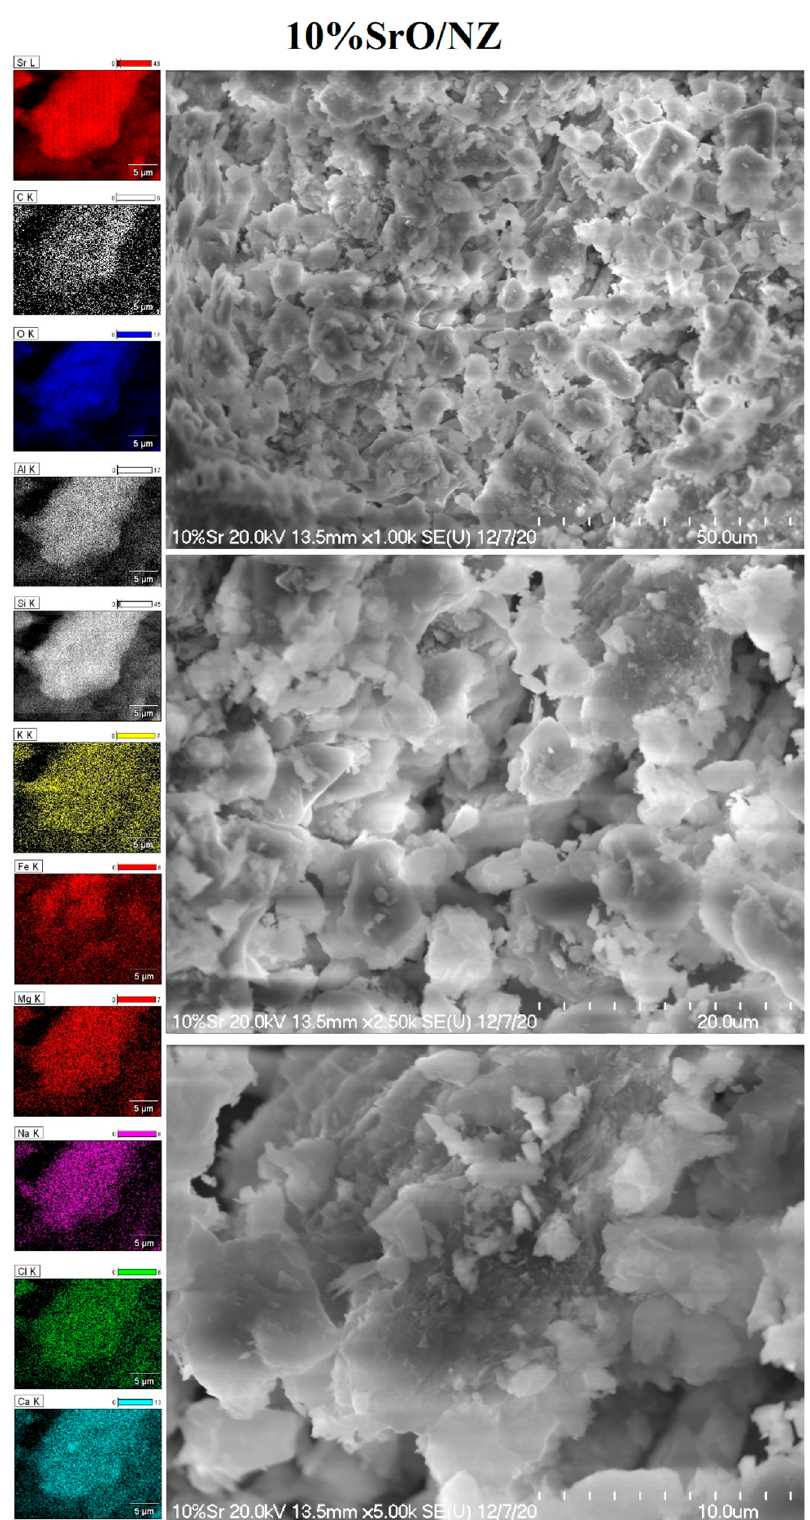
Figure 5. SEM-EDS images of the calcined metal oxide 10% SrO/NZ catalyst in an air atmosphere at 400 °C for 4 h.